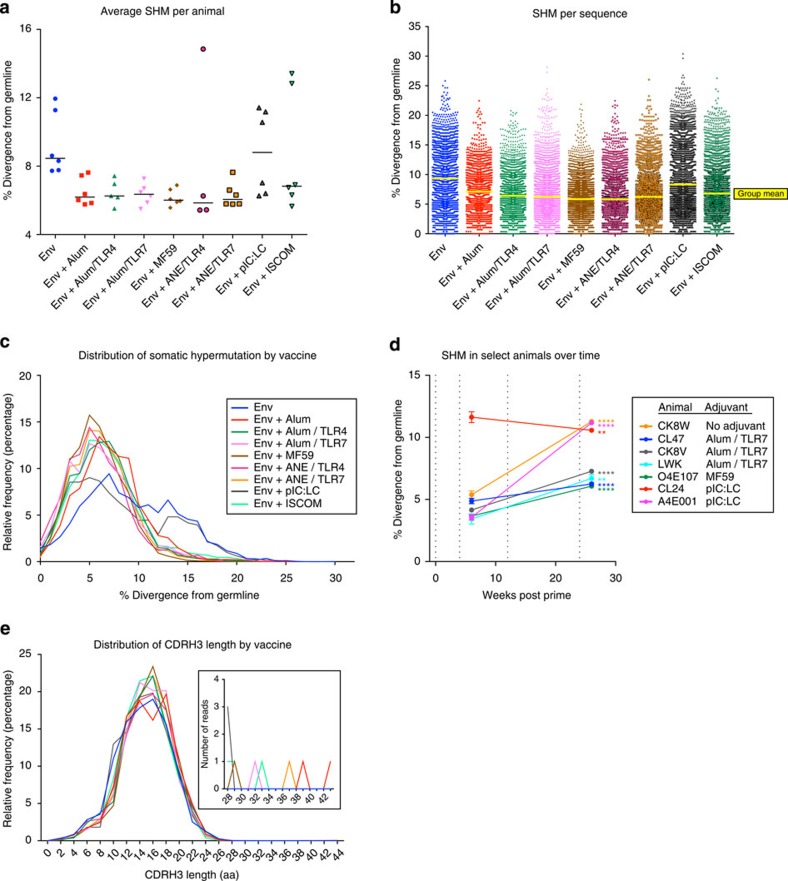
Next-generation sequencing of antigen-specific B cells after protein and adjuvant vaccination.(a) SHM for each animal (n=51) at week 26; each symbol represents the average percent divergence from germline for sequences from a given animal. Horizontal bars indicate the medians. (b) SHM for each vaccine at week 26; each symbol represents the percent divergence from germline for a unique sequence. Horizontal yellow bars indicate the geometric means. (c) Histogram representation of SHM at week 26. The distribution is shown as a composite for all unique sequences from a given vaccine; binning averaged in 2% increments. (d) Effect of boosting on SHM. Percent divergence of antigen-specific cells sorted at week 6 or 26 is depicted for seven animals. Data points represent the mean SHM for each animal; error bars show s.e.'s; vertical dashed lines represent immunization points; n.s., not significant; **P<0.01; ****P<0.0001 compared with week 6 time point by two-way ANOVA. (e) CDR H3 length distribution as a composite from all sequences from a given vaccine; binning averaged in 2-aa increments. Inset highlights the low frequency of reads with long (≥28 aa) CDR H3 regions. Colours denote vaccines as in c.